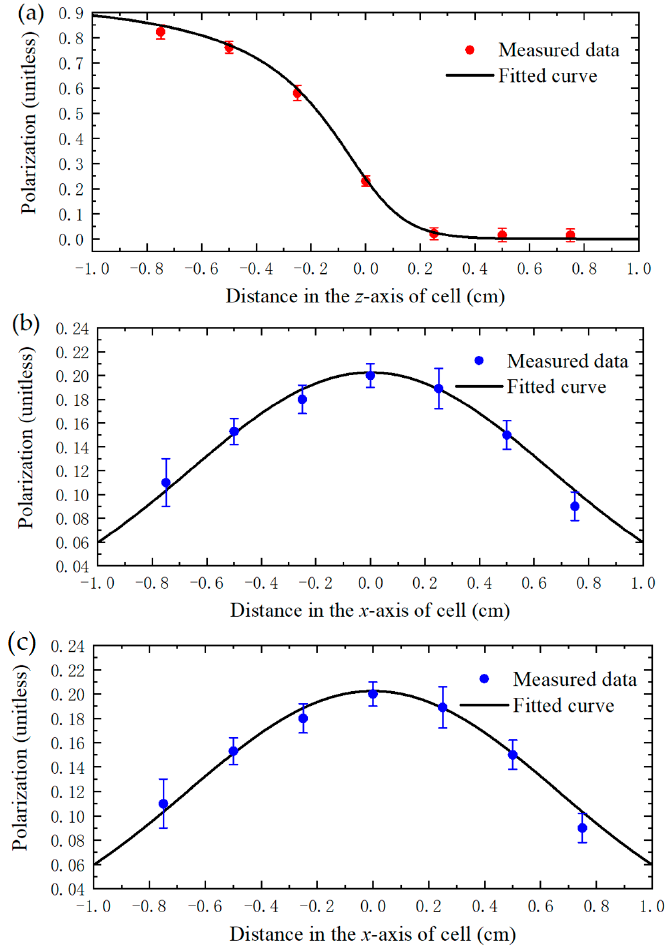
Figure 5. Experimental measurement result of the spin polarization distribution in the z axis in the pump light propagation direction and in the x and y axes in the pump light cross-section direction. The measuring spatial resolution is 0.25 cm, with a measuring range of − 0.75–0.75 cm. The error bars represent the expanded uncertainties of the results. The solid line is the fitted curve obtained by Equations (16)–(18). ( a – c ) is the polarizability measured along the x -, y -, z - triaxial axis respectively.